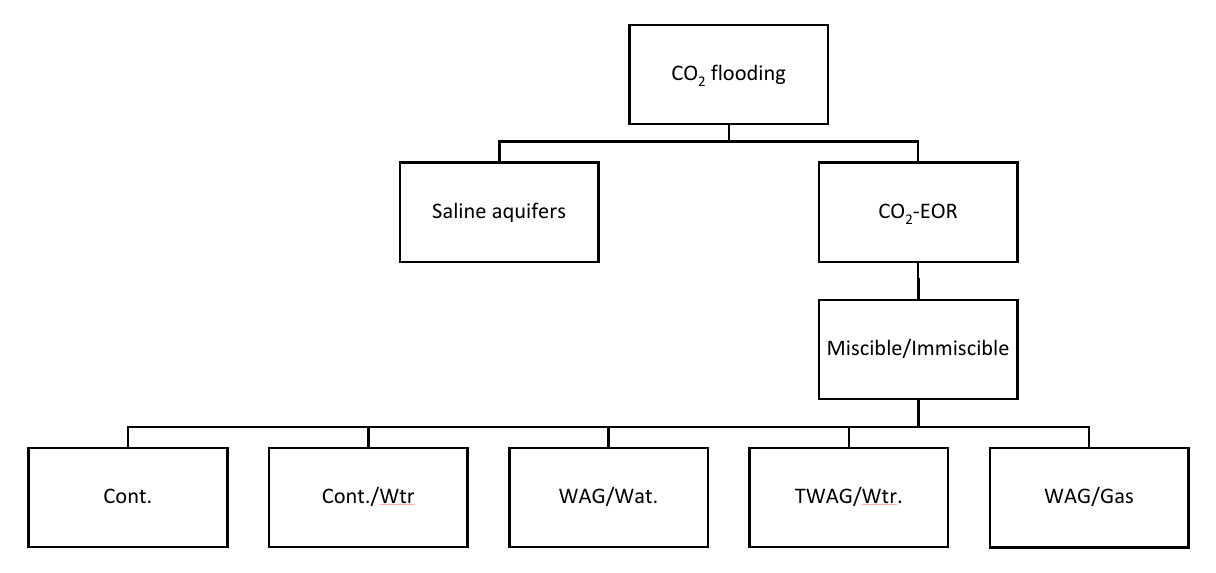
Figure 3. CO 2 flooding techniques: continuous CO 2 injection (Cont.), continuous CO 2 chased with water (Cont./Wtr.), conventional alternating CO 2 and water chased with water (WAG/Wat.), tapped alternating CO 2 and water (TWAG/Wtr.), and alternating CO 2 and water chased with gas (WAG/Gas).